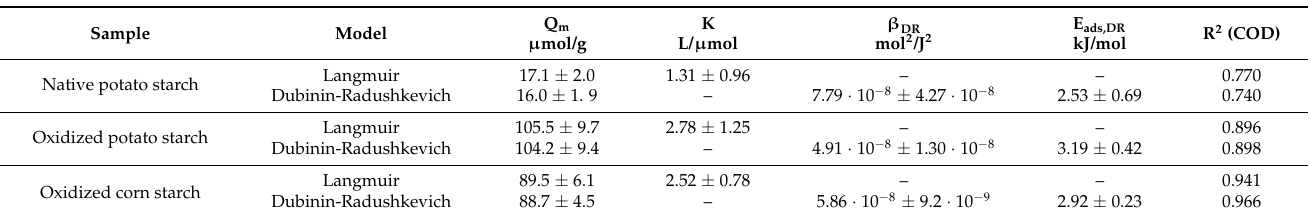
Table 7. Fitting parameters for Langmuir, Sips, and Dubinin-Radushkevich isotherm models for adsorption with decreased adsorbent dose from PbSO 4 solution. Q m thereby is the maximal sorption capacity, K is the equilibrium constant for the respective model, and E ads,DR is the mean free energy of adsorption derived from the Dubinin-Radushkevich model. To the isotherm of native corn starch, no applied model gave a reasonable fit.